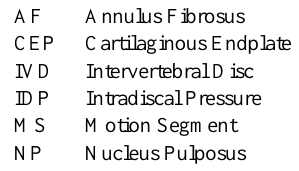
Table A1. List of